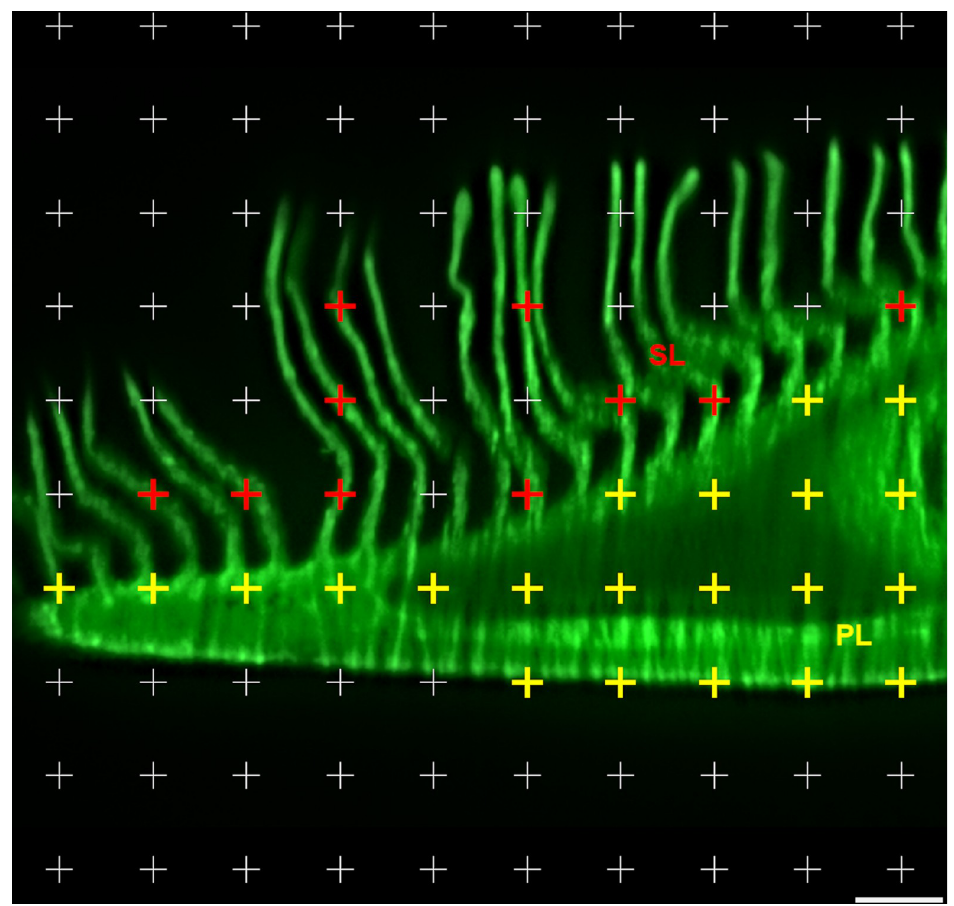
Fig 19. Estimation of V V(SL/GF) in VUR autofluorescence images acquired by LSFM of optically cleared GF samples. For practical reasons, V V(SL/GF) and S V(SL/GF) can be estimated in the same images, i . e ., using SUR sampled fields of view from (virtual) optical VUR sections. In the presented example of a SUR sampled field of view of a (virtual) GF VUR section, the vertical axis is not indicated. A (virtual) grid of equally spaced test points (crosses) is superimposed on the SUR sampled test field. All points hitting GF section profiles (P (GF) ) (including PL section profiles (P (PL) , yellow crosses) and SL section profiles (P (SL) , red crosses)) are counted [in the presented example: 21 P (PL) and 10 P (SL) , i . e ., 31 P (GF) ]. V V(SL/GF) is calculated from P (SL) and P (GF) , using Eq 4 . LSFM-autofluorescence image acquired at 520/40 nm (ex) and 585/40 nm (em). Bar = 100 μ